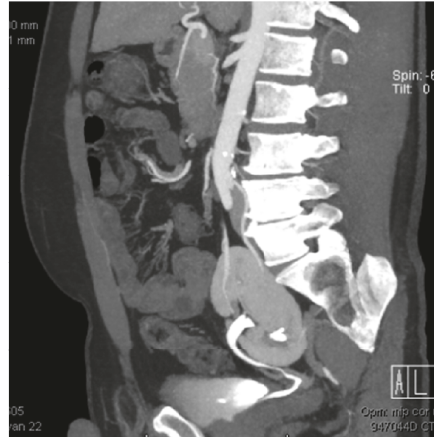
Figure 2: CT scan with sagittal image of ectopic left pelvic kidney showing the upper and middle polar artery.